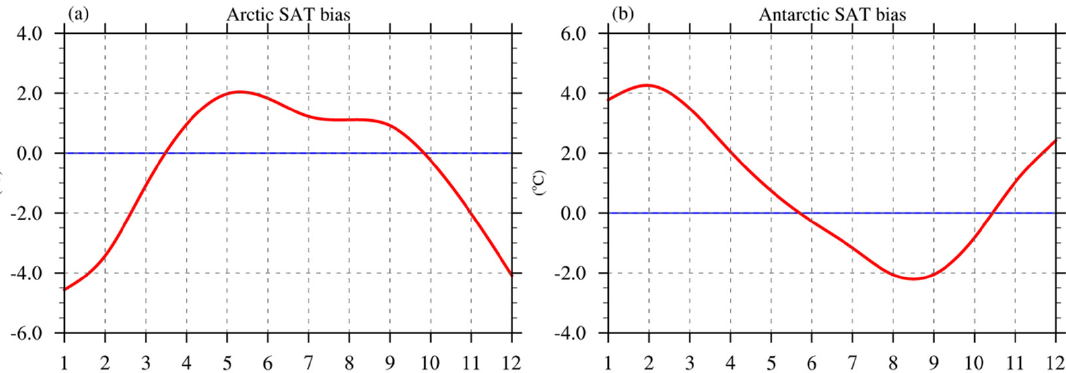
Figure 4. Spatial patterns of ( a , c ) SSMI observations from September 1980–2014 and ( b , d ) CAS- ESM 2.0 ensemble mean sea ice concentrations for September 1979–2014 in historical simulation, in Northern Hemisphere (upper panel) and Southern Hemisphere (lower panel).